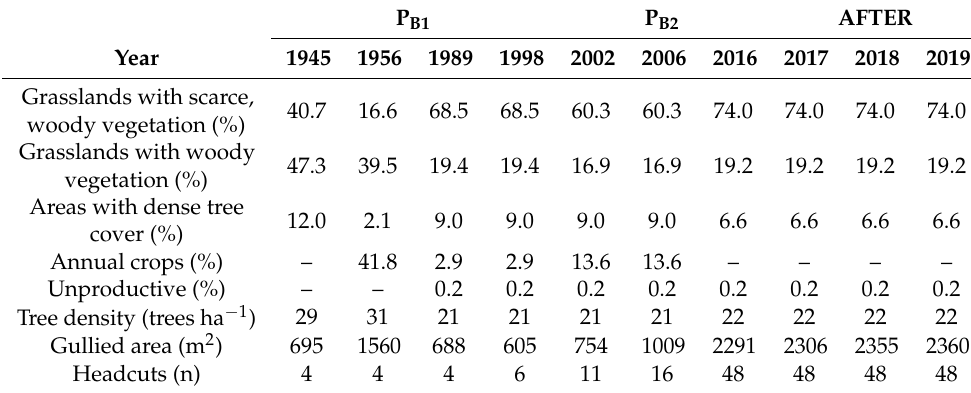
Table 4. Evolution of gullied area, besides land use and vegetation cover in the catchment. Data from 1945 to 2006, taken from G ó mez-Guti é rrez et al. [11]. P B1 P